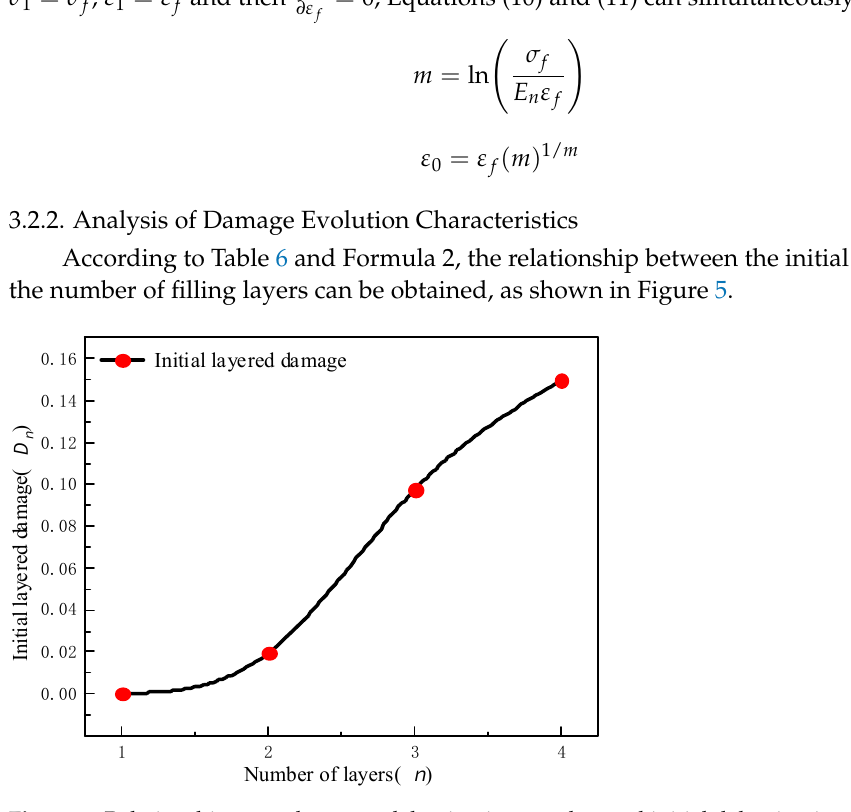
Figure 5. Relationship curve between delamination number and initial delamination damage.